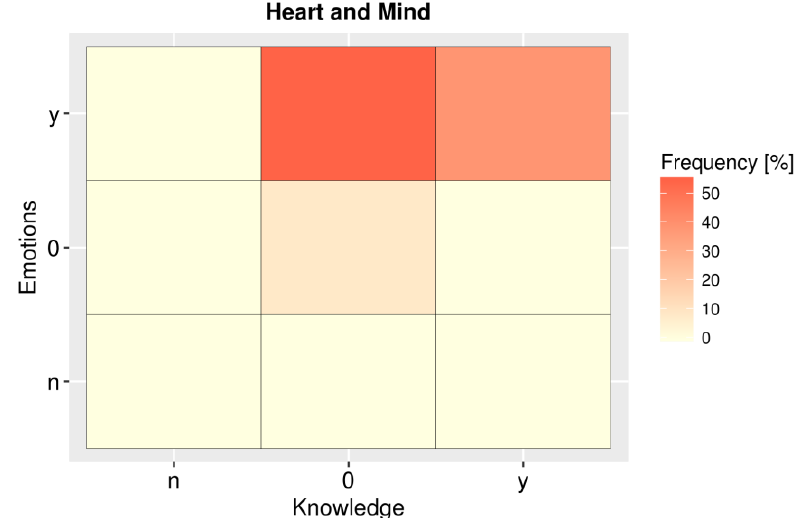
Figure 8. Frequency of responses compared between the knowledge and emotions dimensions—heart and mind theme.